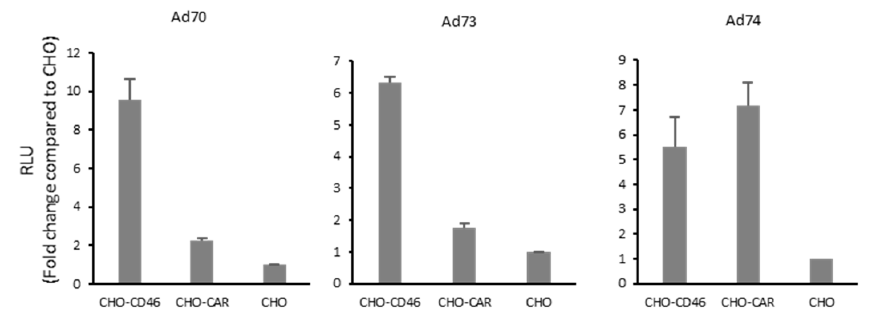
Figure 6. Receptor usage screening of new species D human adenoviruses. Cells were infected at 100 viral particles per cell and luciferase expression was measured 26 h post-infection by addition of furimazine substrate and expressed as relative light units (RLU). Levels were compared to the normal CHO cells and indicated as fold change. In all cell lines, error bars represent mean ± SD ( n = 3).